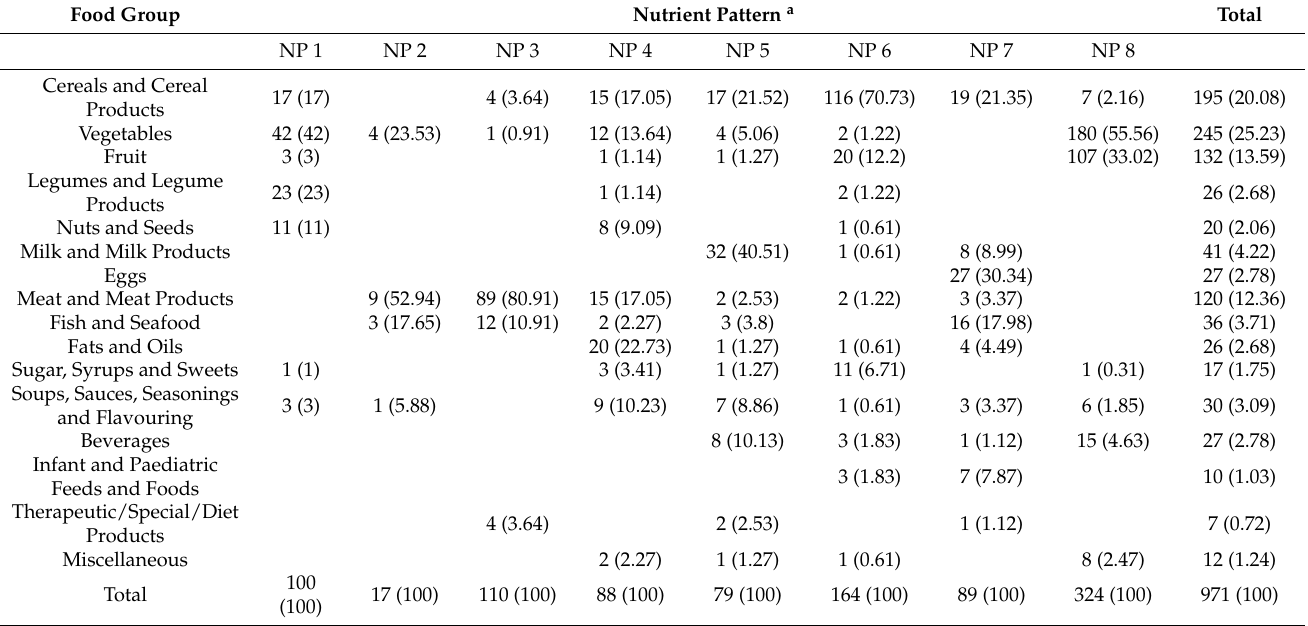
Table 4. Food group percentage for each nutrient pattern (NP); n